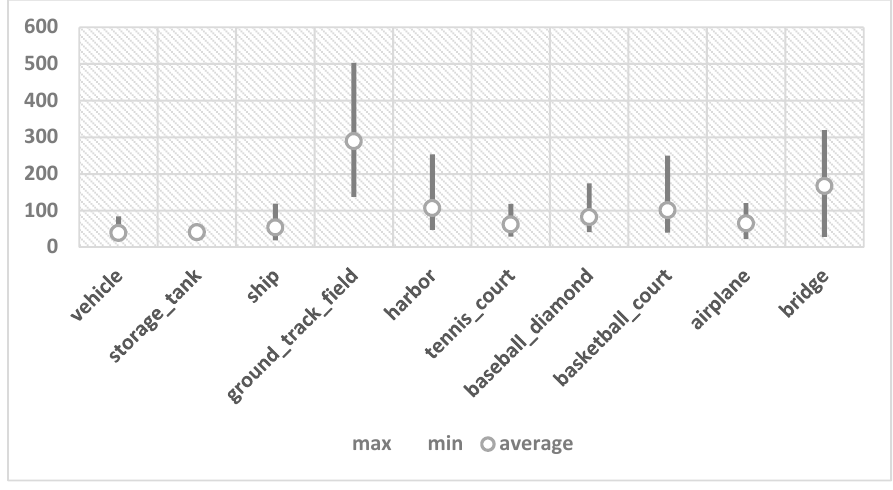
Figure 14. Range of the sides of true bounding boxes in the NWPU VHR-10 dataset.